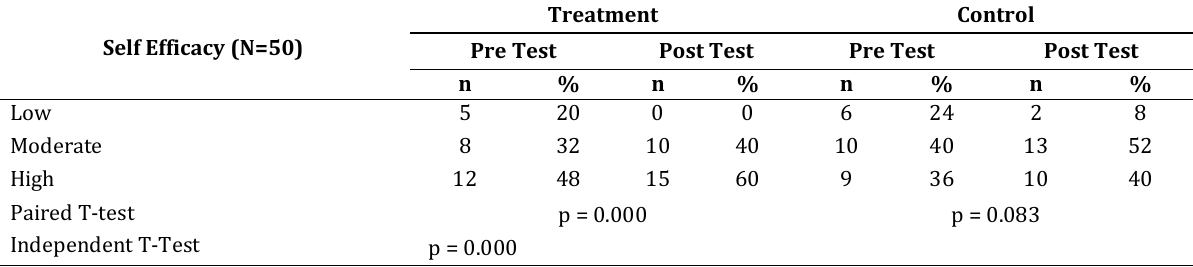
Table 2 .The Results of Self-Efficacy Before and After being Given Psychoeducation Therapy in the Treatment and Control Groups of Breast Cancer Patients (Ca Mammae) (n=25).